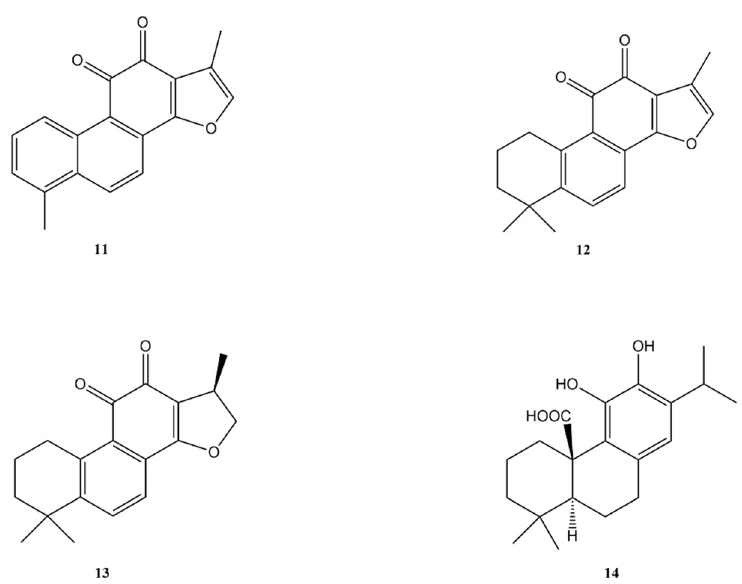
Figure 2. Bioactive abietane diterpenes: Tanshinone I ( 11 ); Tanshinone IIA ( 12 ); Cryptotanshinone ( 13 ); Carnosic acid ( 14 ).